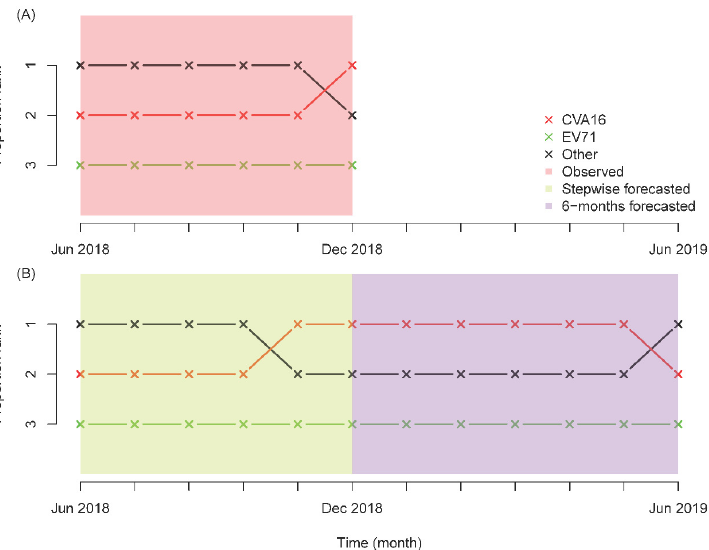
Figure 5. Predicted and observed trends in genotype frequency of HFMD in Guangzhou, China. ( A ) and ( B ) indicate the observed and forecasted genotype frequency, respectively.